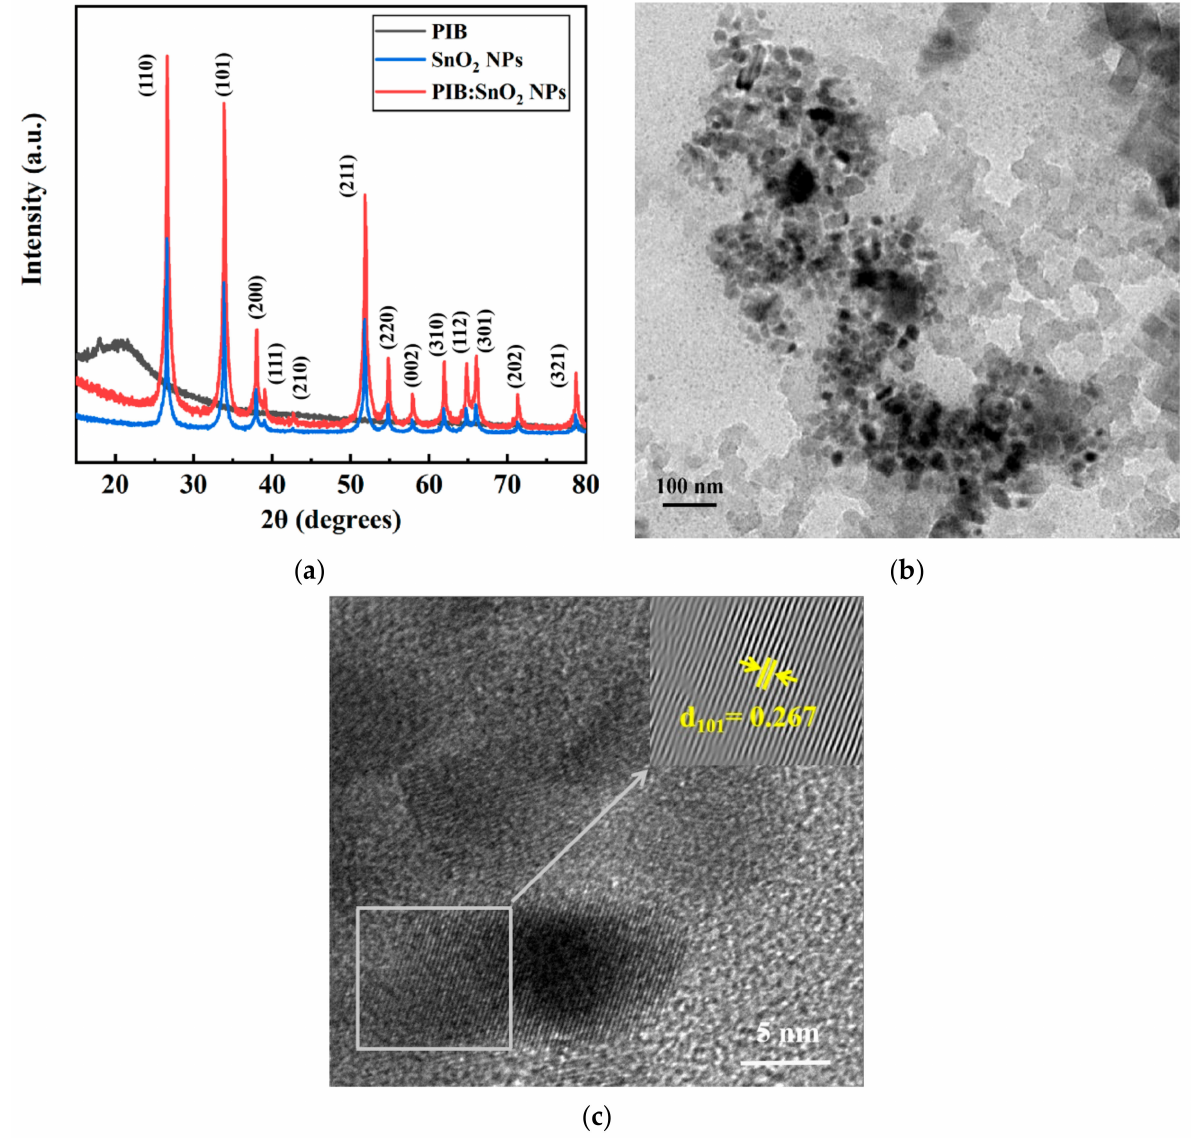
Figure 3. ( a ) XRD spectrum of SnO 2 NPs and PIB: SnO 2 NPs. ( b ) TEM of SnO 2 NPs dispersed in PIB toluene solution. ( c ) High-resolution TEM